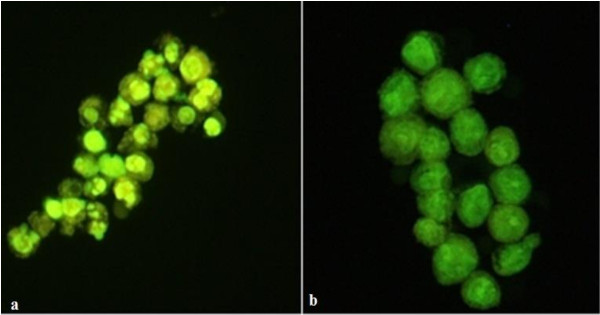
Effect of partially purified P. linteus polysaccharide extract on the morphology of THP-1 cells. (a) THP-1 cells cultivated with 1 mg/mL P. linteus polysaccharide extract for 24 h. Cells show strong shrinkage, nuclear condensation and nuclear fragmentation into apoptotic bodies. Cells were stained with an AO/EB mixture and immediately photographed using excitation/emission at 485/530 nm using a 20× objective. (b) Control THP-1 cells.